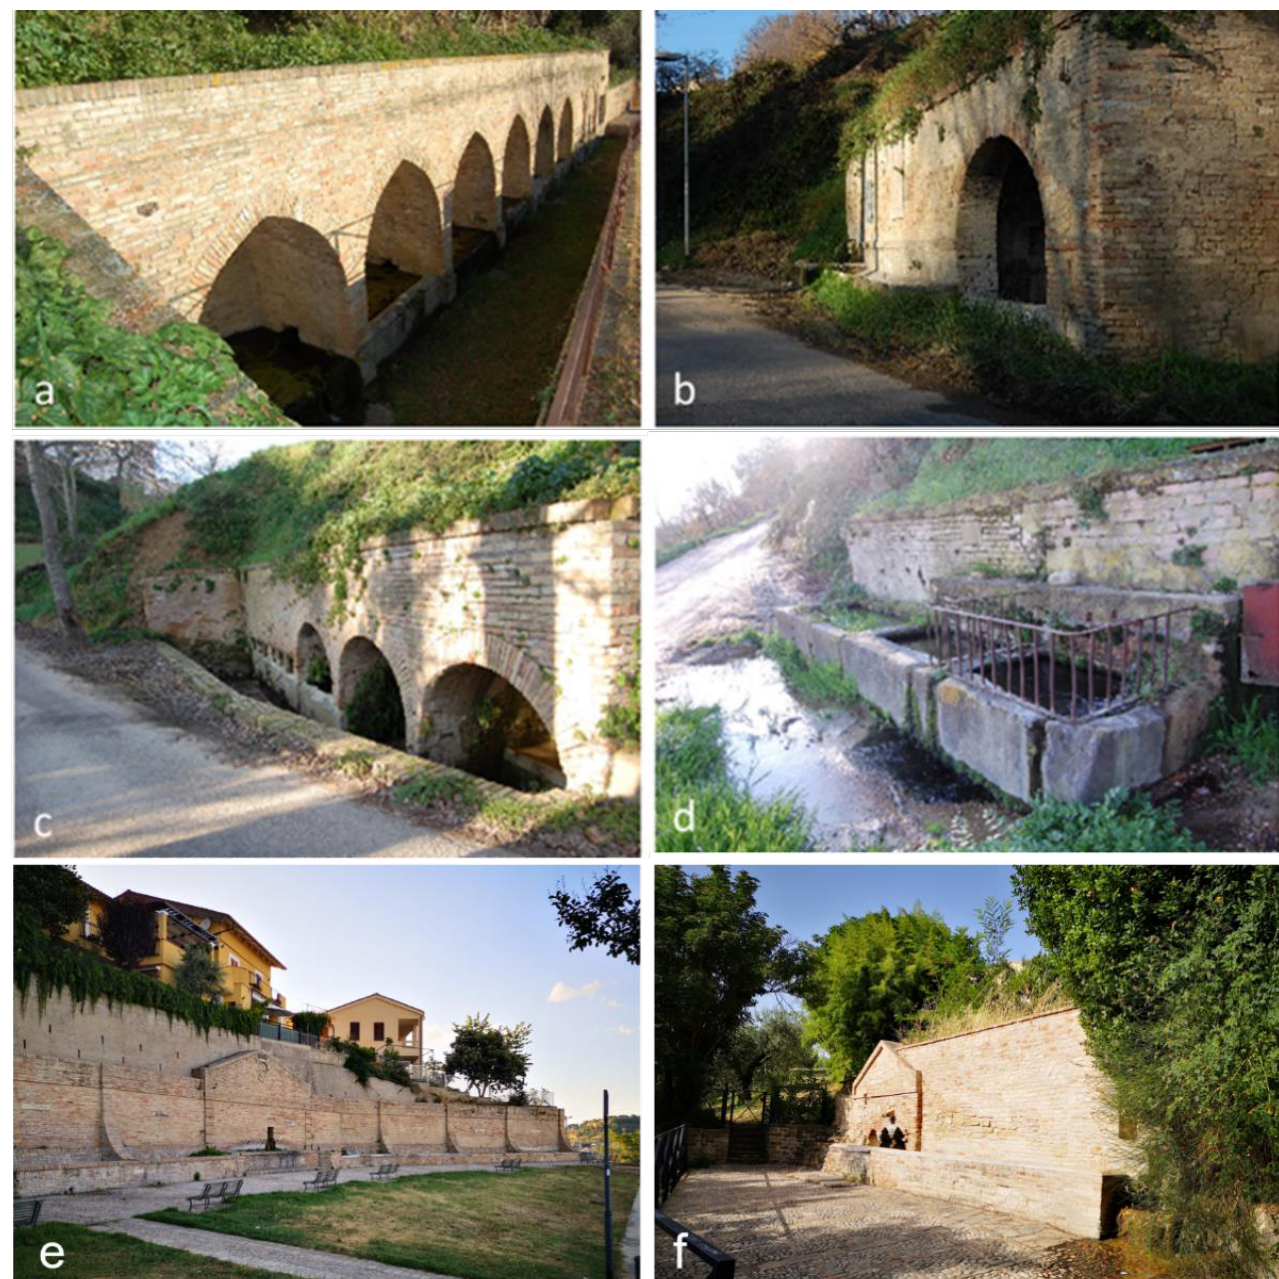
Figure 3. Some examples of tapped springs of the study area discharging at the interface between permeable and non-permeable lithotypes located at the border of the historical town of Atri ( a – d ), Chieti ( e ), and Pescara ( f ); ( a , e , f ) are examples of architectural restoration.